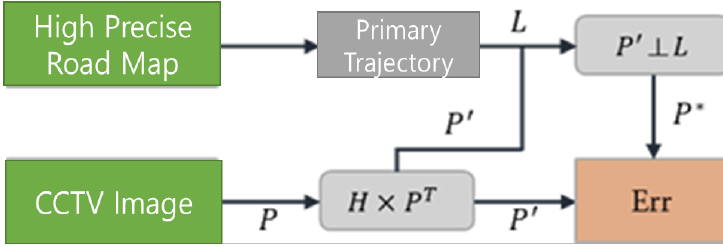
Figure 6. Definition of a homography matrix for projection (not real world).